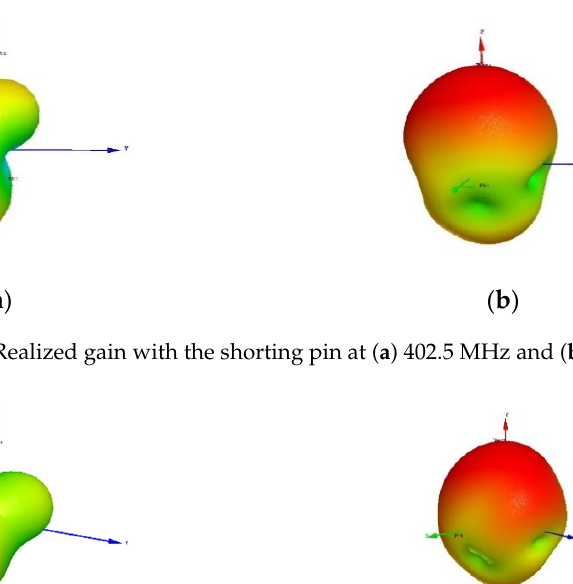
Figure 12. Realized gain without elements upon the patch at ( a ) 402.5 MHz and ( b ) 2.45 GHz.